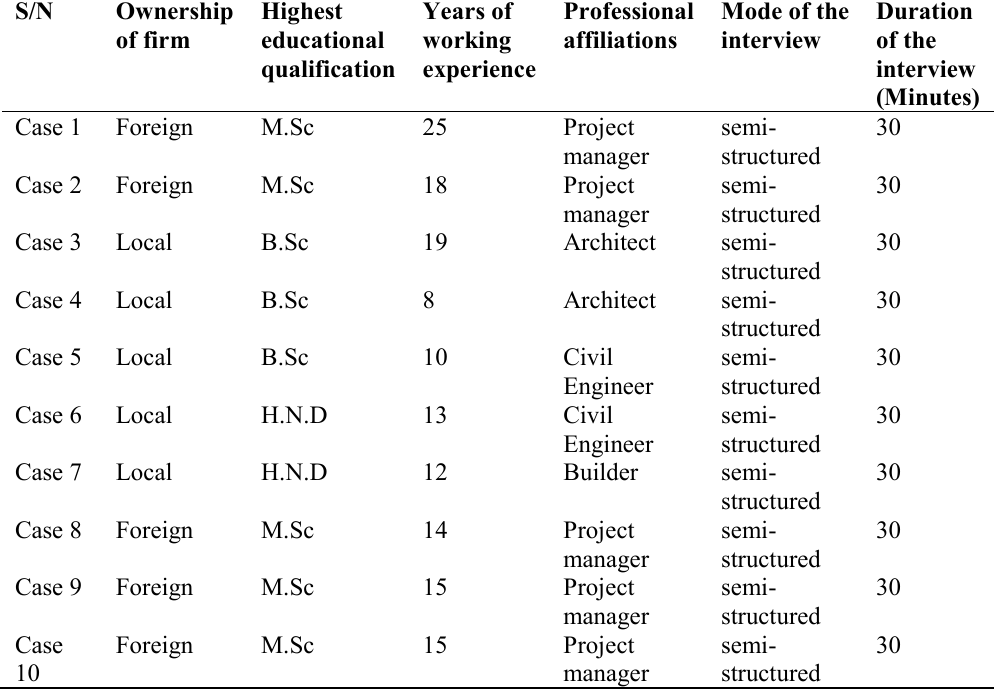
Table 5. Respondents’ Characteristics (developed by the